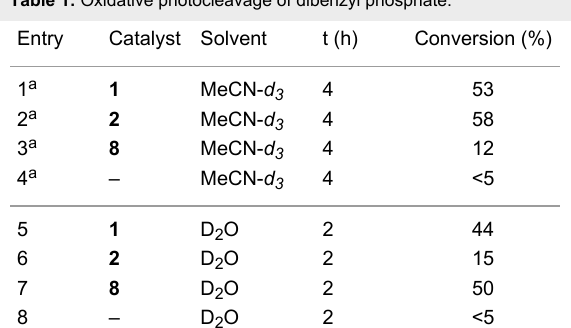
Table 1: Oxidative photocleavage of dibenzyl phosphate.